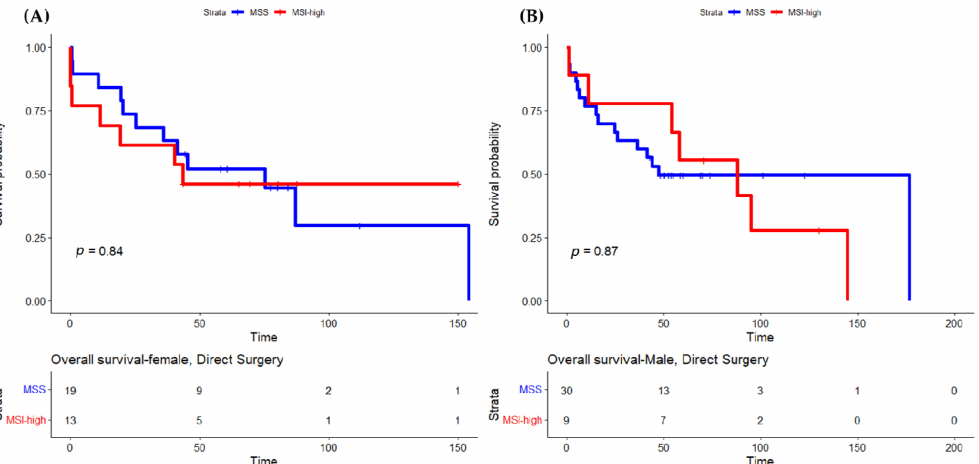
Figure 3. Overall survival by MSI status in females ( A ) and males ( B ) treated with direct surgery. MSI, microsatellite instability; MSS, microsatellite stable.